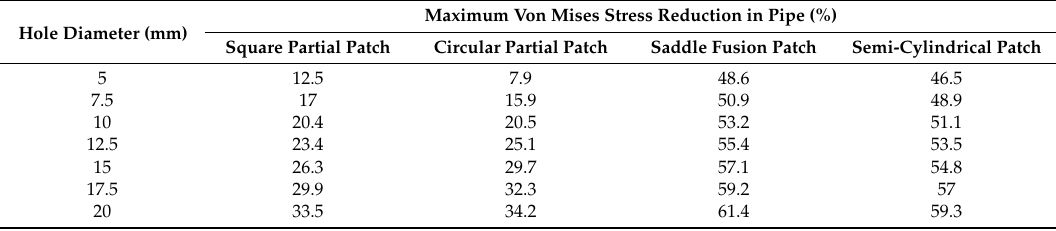
Table 6. Maximum Von Mises stress reduction percentage in the holed pipe for various patch arrangements under internal pressure.